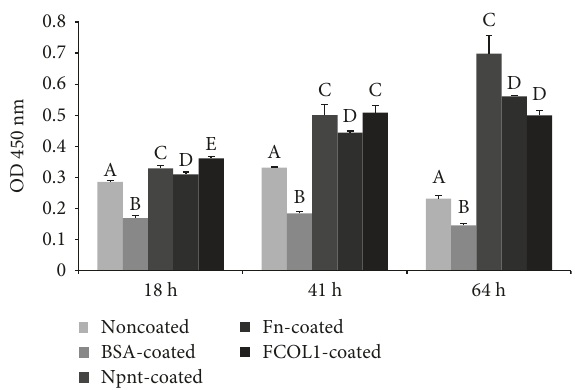
Figure 4: Cell proliferation in the absence of serum. hDPSCs (passage number 5) were seeded into 96-well plates (non-PS) at the concentration of 8 × 10 3 /well in FBS-free DMEM. Cell proliferation was recorded using CCK-8 reagent at 18h, 41 h, and 64h postinoculation. Di ff erent symbols represent signi fi cant di ff erences in each separate time point, p < 0 01 by post hoc Tukey ’ s HSD